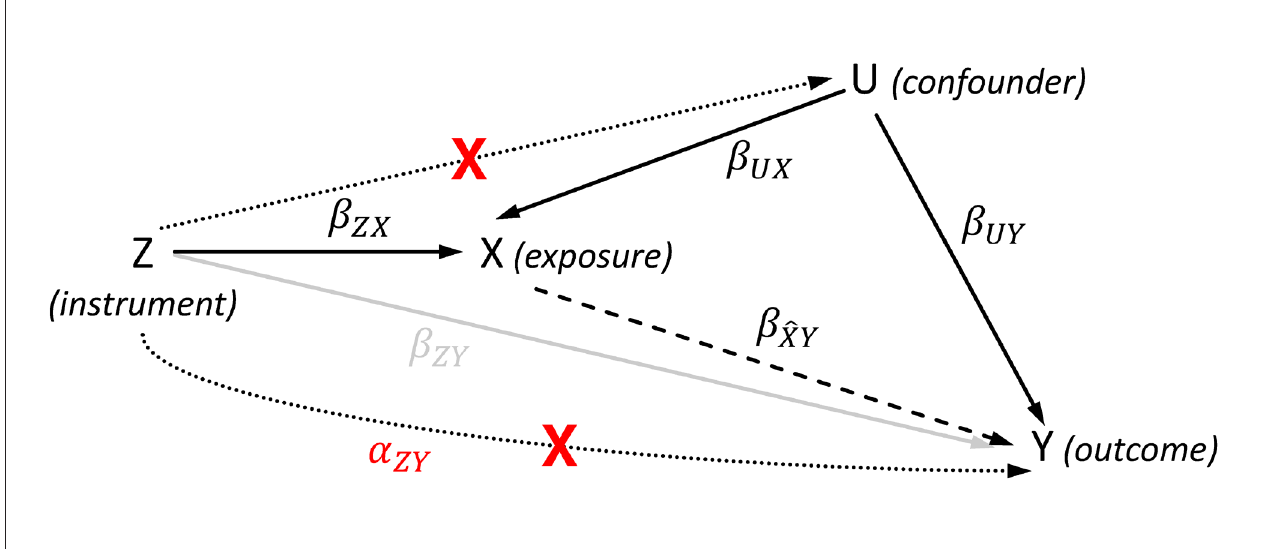
FiGuRe 1 | Directed acyclic graph showing the effects β of the genetic instrument Z , the exposure X , the outcome Y and the (unobserved) confounder U for illustrating the Mendelian randomization (MR). The dashed line represents the estimated causal effect β ˆ XY using the instrumented exposure. The dotted lines show violations of the MR assumptions 2 (lower line) and 3 (upper line), and are marked by a red cross. The α ZY represents the effect of the instrument that affects the outcome not via the exposure in case of violating the exclusion restriction assumption. In contrast to α ZY , the gray line illustrates the SNP-outcome association with its effect β ZY that is used to calculate the two-sample MR given a valid